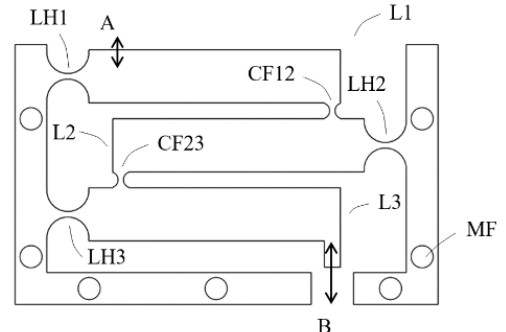
Figure 2. Conceptual design A, lever arm height 7 mm, width 5 mm, flexural hinge radius 3 mm, flexural section thickness 1 mm, coupling joint radius 1 mm, flexural section thickness 1 mm; mechanical advantage of each lever 5; MF indicating holes for mounting onto a back plate.